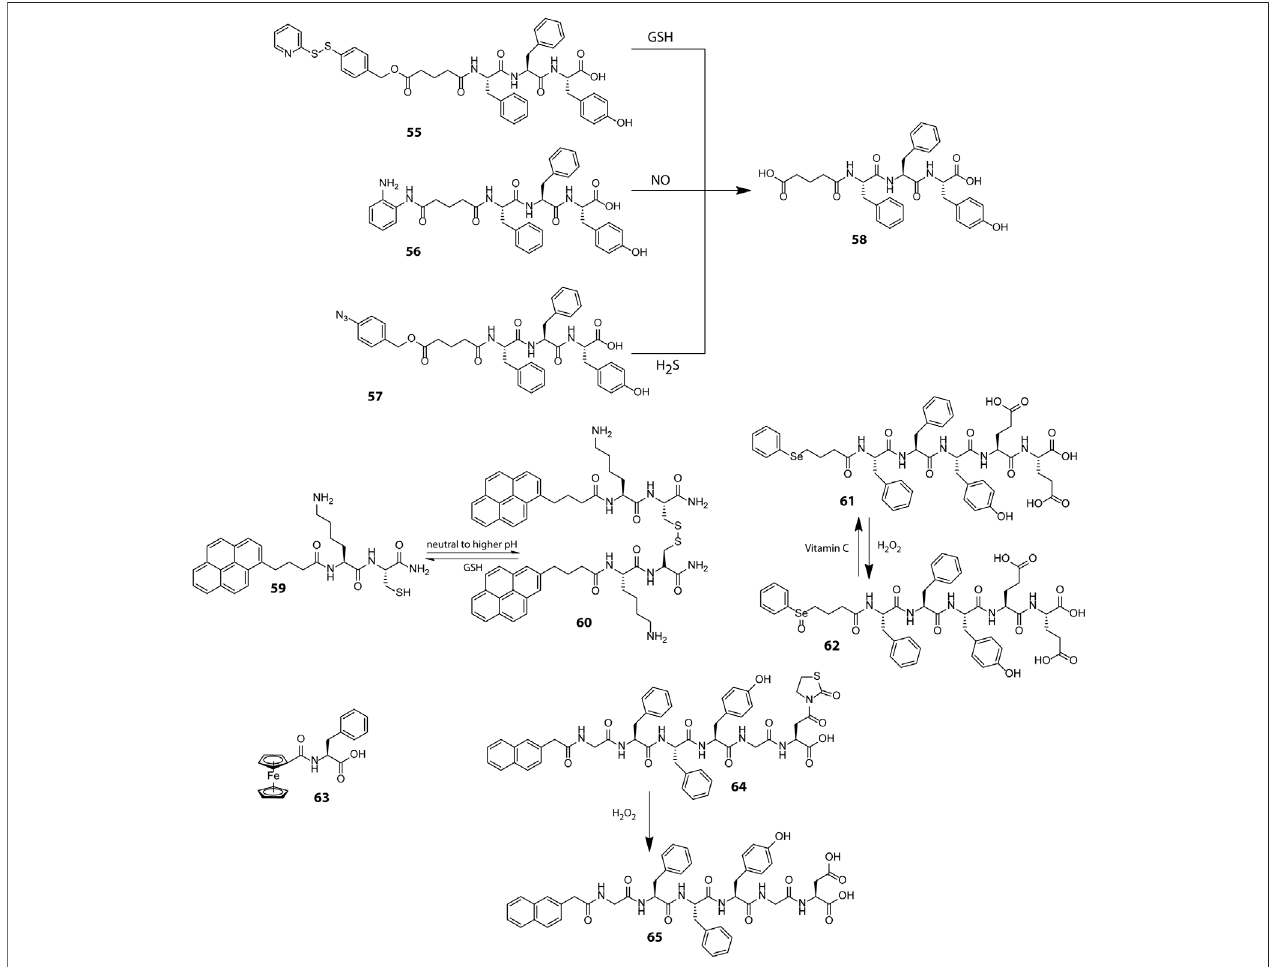
Scheme 2 | Chemical structures of representative peptides used for preparing redox responsive hydrogels with therapeutic applications.